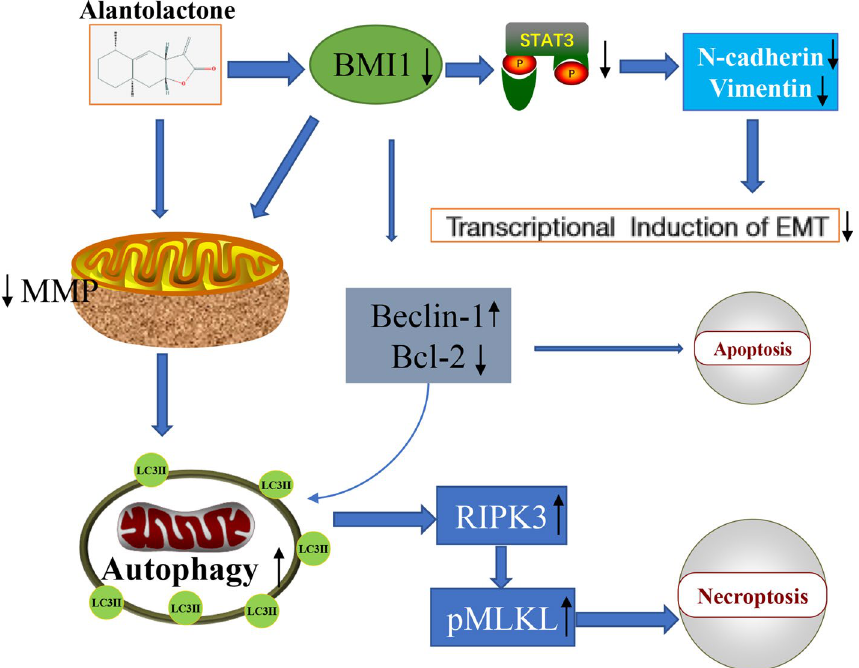
Figure 7. Schematic diagram of the mechanisms contributing to AL inhibiting cervical cancer progression. AL causes depletion of BMI1 to induce autophagy-dependent necroptotic cell death and inhibits epithelial- mesenchymal transformation through the STAT3 signaling pathway in cervical cancer